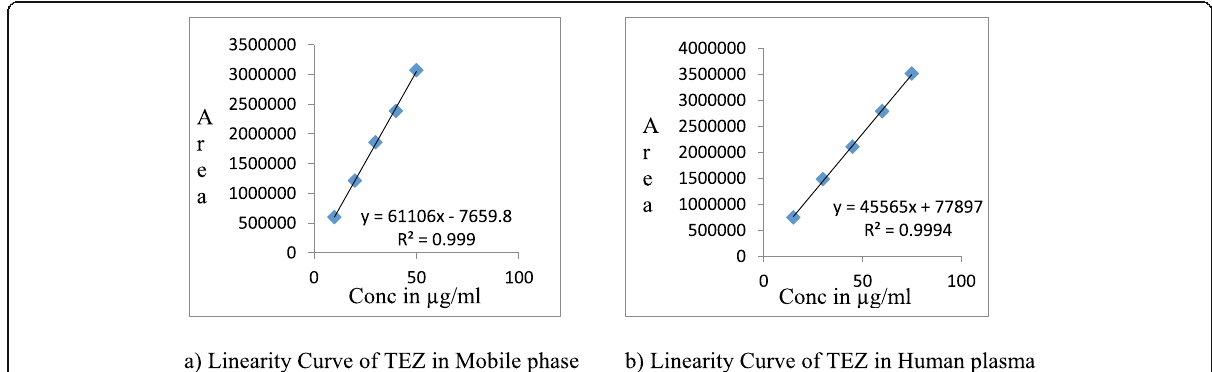
Fig. 6 Linearity plot of Tezacaftor in mobile phase and human plasma respectively. a Linearity curve of TEZ in mobile phase. b Linearity curve of TEZ in human